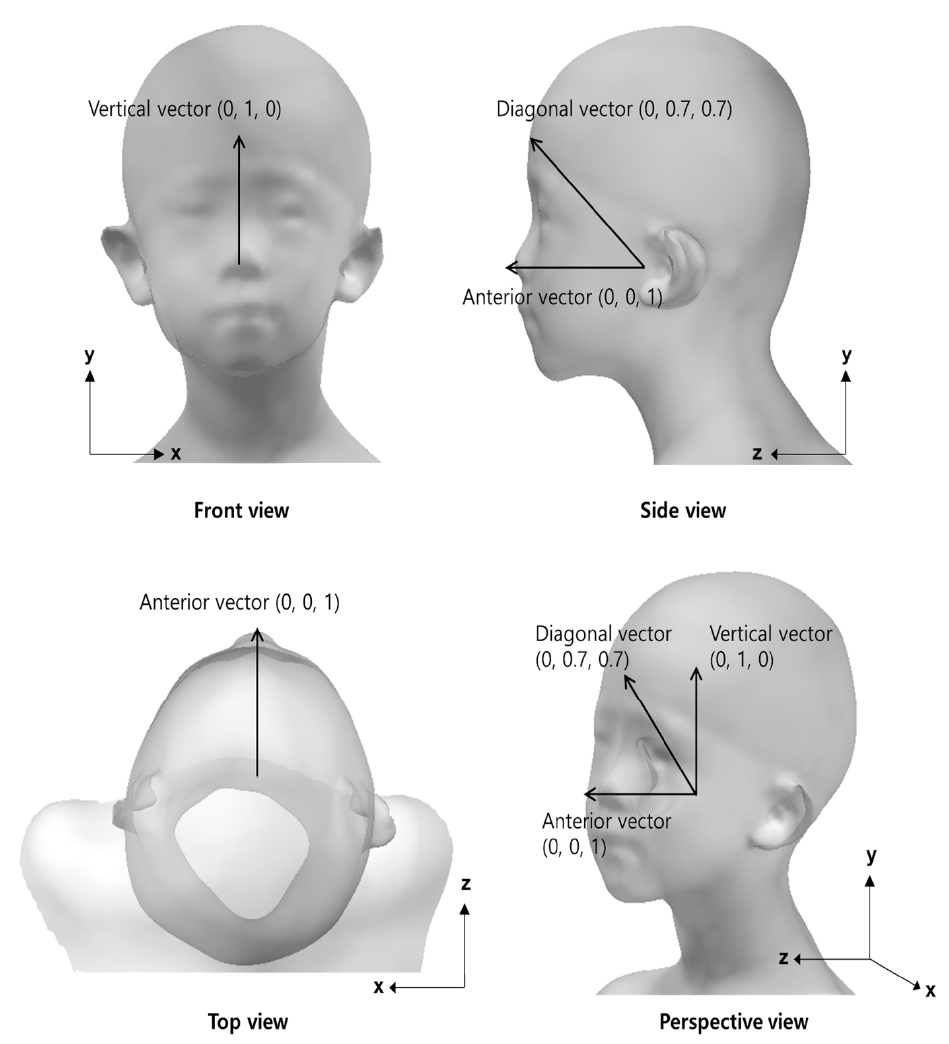
Figure 5. Reference vectors for measurement of head angles.